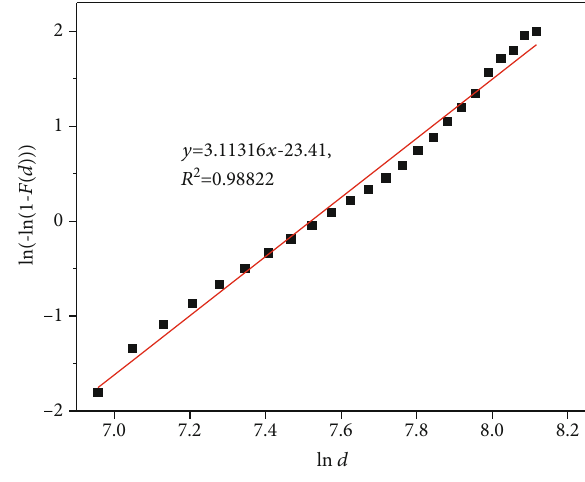
Figure 6: Histogram of coal particle size distribution of the coal sample.